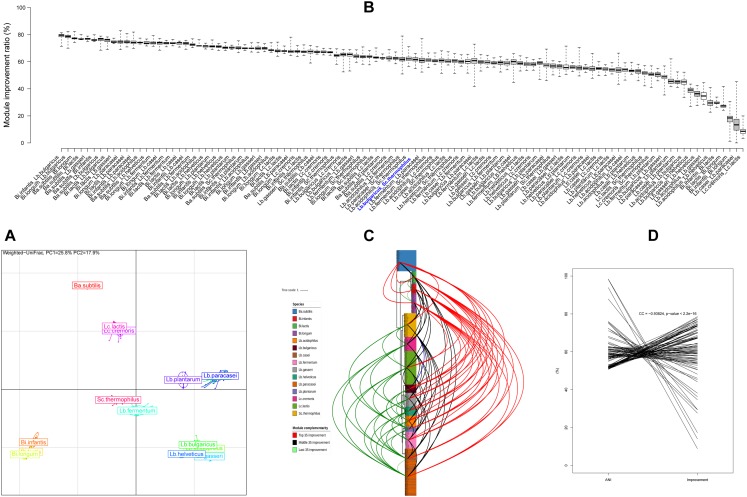
KEGG module feature and complementarity. (A) Principal components analysis based on the KEGG module integrity profile for all strains. Isolates on the first and second principal components (PC1 and PC2) are plotted by nodes. Lines link strains of the same species, and colored circles pack the strains near the barycenter for each species. (B) Module complementarity at strain level. (C) Module complementarity at species level showed on the phylogenetic tree with three groups; red lines, top 1/3 combination; black lines, medium combination; green lines, last 1/3 combinations; blue lines, the classical combination of Lb. bulgaricus and Sc. thermophilus. (D) Correlation between ANI and module complementarity at species level.